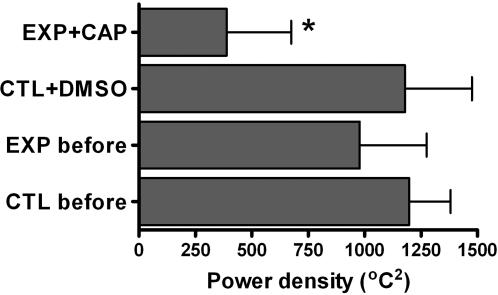
The total power density, i.e. the intensity of periodic body temperature cycles, is significantly less when TRPV1 and TRPM8 were blocked, compared to the other treatments which do not differ significantly from each other (CTL = control animals, EXP = experimental animals, DMSO = DMSO treatment, CAP = capsazepine treatment; means from all animals±s.e. are shown).